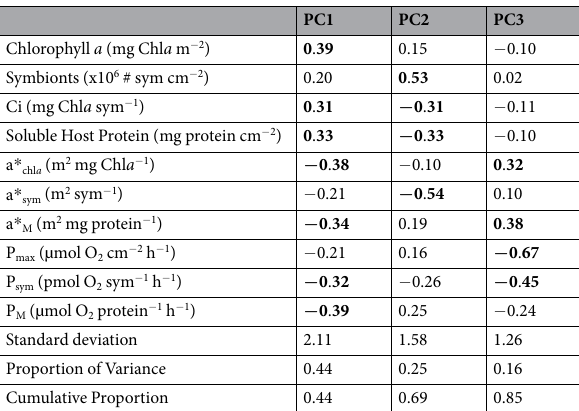
Table 1. Principal component analysis (PCA) loadings for the variation of the structural, optical, and photo- physiological coral traits of the winter and summer coral phenotypes (control organisms). The cumulative variation accounted for by each principal component is also shown. In bold are highlighted the highest correlations [loading > 0.3] between parameters and PCs.